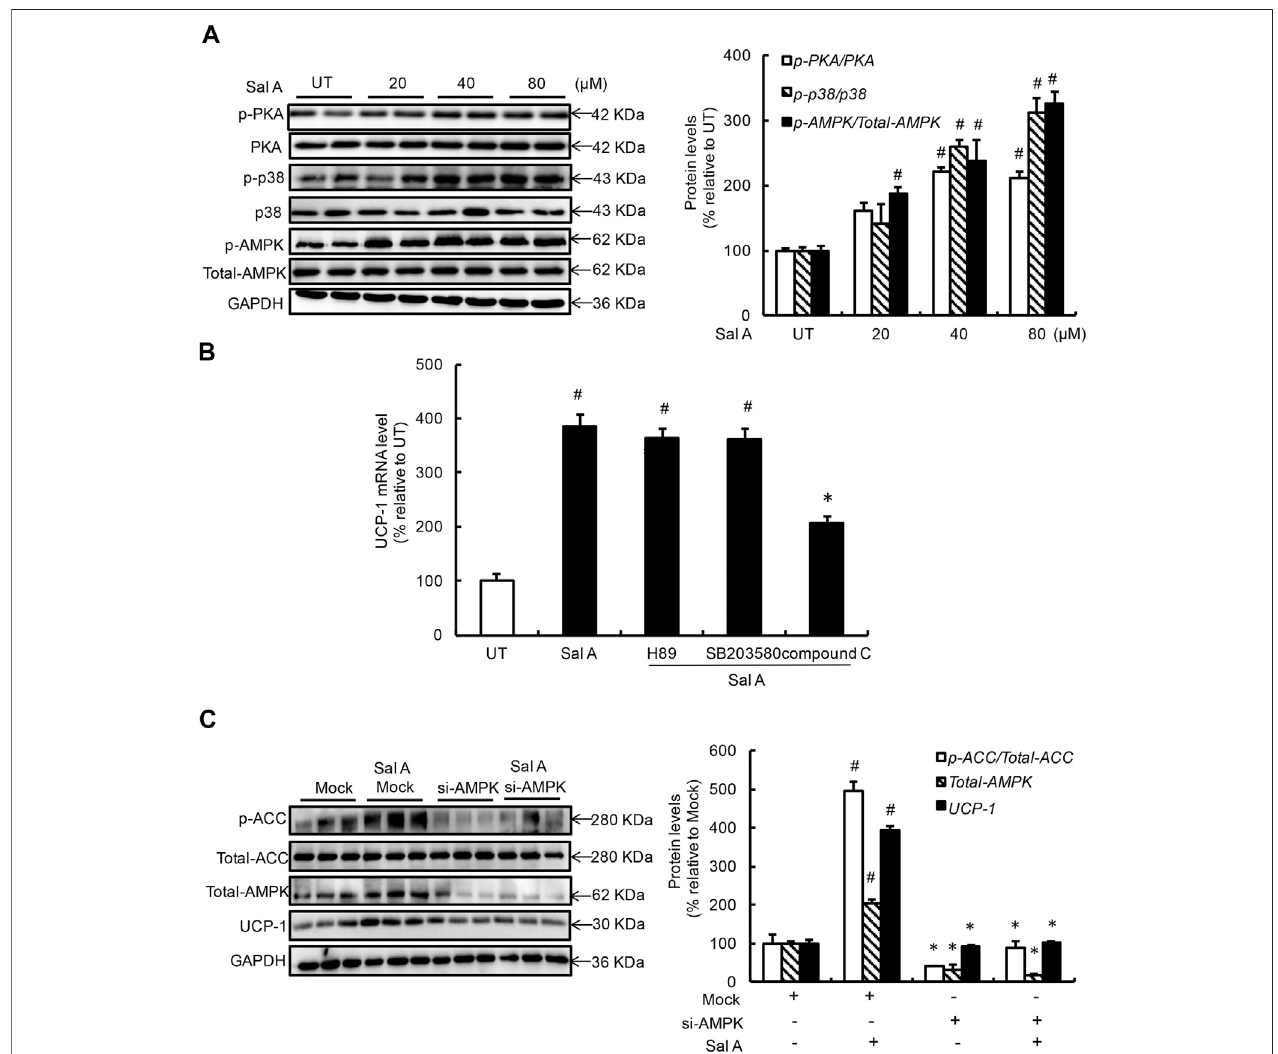
FIGURE 2 | AMPK activation contributes to Sal A-induced UCP-1 upregulation. (A) Differentiated C3H10T1/2 adipocytes were treated with Sal A (0, 20, 40, and 80 μ M)for4 h,intracellular p -PKA,PKA,p-p38,p38, p -AMPK,andAMPKcontentsweredeterminedbyWesternblot. (B) Fully-differentiatedC3H10T1/2cellswerepre- treated with PKA inhibitor (H89, 20 μ M), p38 inhibitor (SB203580, 10 μ M), and AMPK inhibitor (compound C, 1 μ M), respectively, for 2 h before incubated with Sal A (80 μ M)for4 h.IntracellularUCP-1mRNAlevelwasmeasuredbyRT-PCR. (C) Fully-differentiatedC3H10T1/2adipocytesweretransfectedwithsiRNAsforAMPK. AftersilencingAMPKbysiRNA,cellswereexposedto80 μ MSalAfor4 h.TheproteinlevelsofUCP1,AMPK, p -ACCandACCweredetectedbyWesternblot.Allvalues are denoted as means ± SD from three independent batches of cells. # p < 0.05 vs. the UT or Mock; * p < 0.05 vs. the Sal A treatment group. All groups contain two or three samples ( n (cid:1) 2 or n (cid:1)